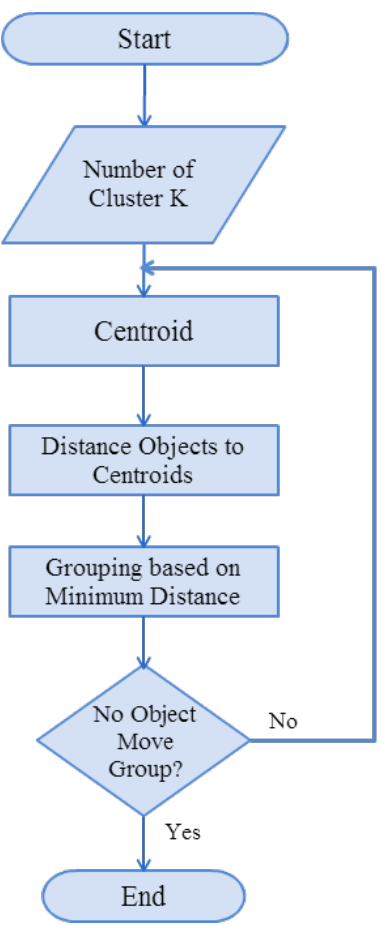
Figure 15. Flowchart of K-means